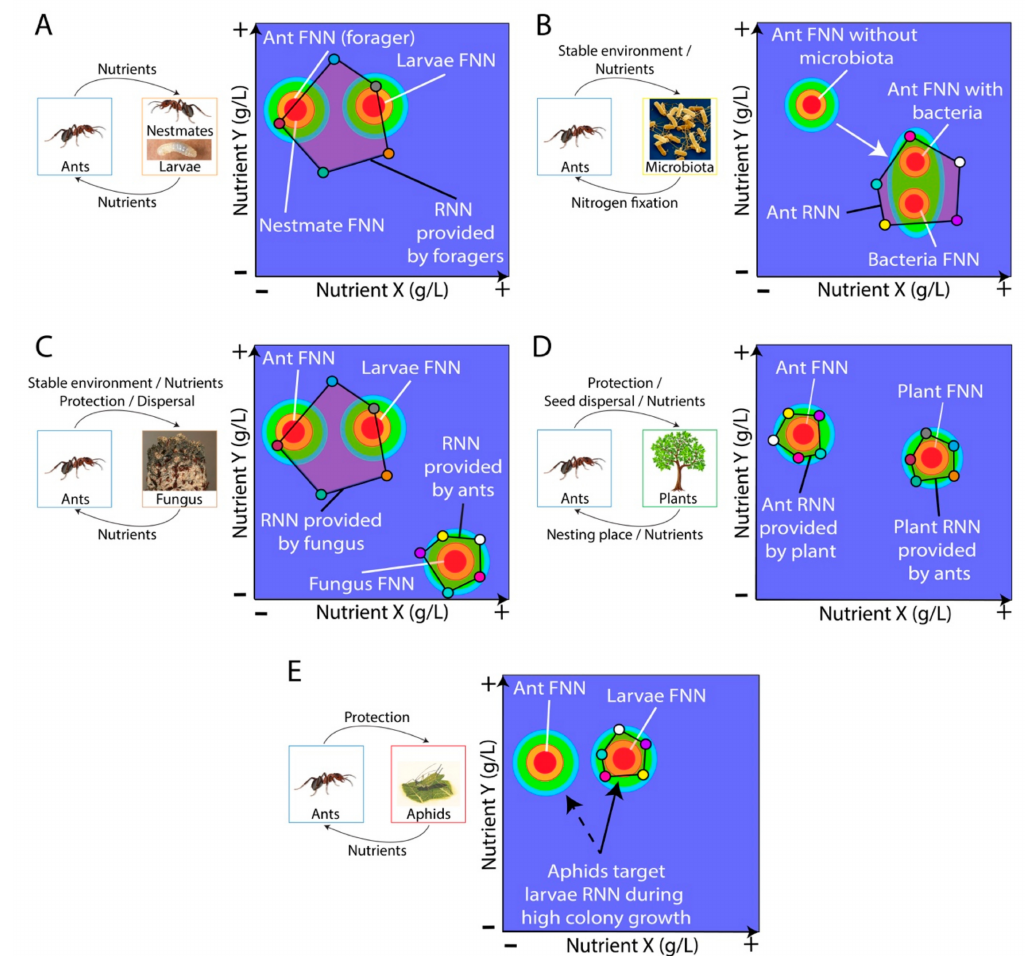
Figure 4. Predicting how ants navigate nutritional landscapes depending on their social environment. Light purple polygons represent RNNs harvested by foraging ants that are bounded by the nutrients contained in five foods shown in Figure 3C. ( A ) We predict adult ant nestmates have similar FNNs compared to more protein-biased FNNs of developing larvae. Despite these FNN di ff erences, ants will collectively forage (i.e., nutrient averaging) to harvest a RNN that matches both adult and larval needs. ( B ) We predict that an ant’s FNN will change if it is experimentally deprived of its gut bacteria [45], and that a hypothetical bacterial species has its own FNN, which may influence the foraging behavior of its host ants closer to its own needs. ( C ) In the mutualism between attine ants and their domesticated fungal cultivars, ants provision their fungus with substrates harvested from the environment (e.g., fresh vegetation or detritus) and fungi assimilate these nutrients and concentrate them in fungal tissue consumed by the ants (gongylidia or hyphae). Nutrient exchange is thus bidirectional—ants provide their cultivars with a RNN and vice versa. We predict that provisioning a fungal cultivar—unique among ants to the attines—poses unappreciated nutrient-cognition challenges because its FNN is farther away from the adult ants than developing larvae. ( D ) Ants and plants exchange nutrients in diverse ways, reflecting the many evolutionary origins of these mutualisms. We generally predict that ants may provide a host plant with an RNN (e.g., through their nest) that should target a plant’s FNN so that it can maximize production of edible resources (e.g., Beltian bodies) whose RNN matches the ant’s FNN requirements. ( E ) Ants also exhibit diverse nutritional mutualisms with other insects. Here, we focus on aphids that provide ants with secreted honeydew, and predict that aphids can